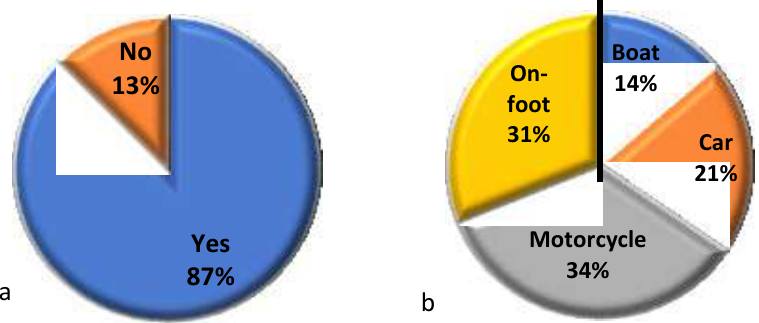
Figure 4. (a) Accessibility, (b) Type of Transportation mode (Source: Research data,